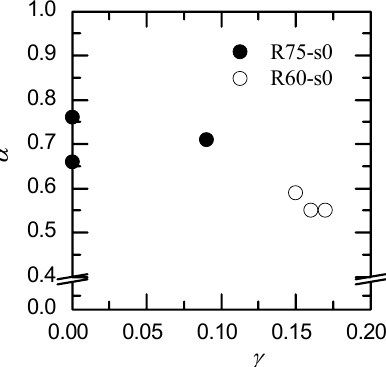
Fig. 6 Reaction rate, α , and preferential generation rate of CO, γ , in the cases of parallel-type multi-jet ( Q